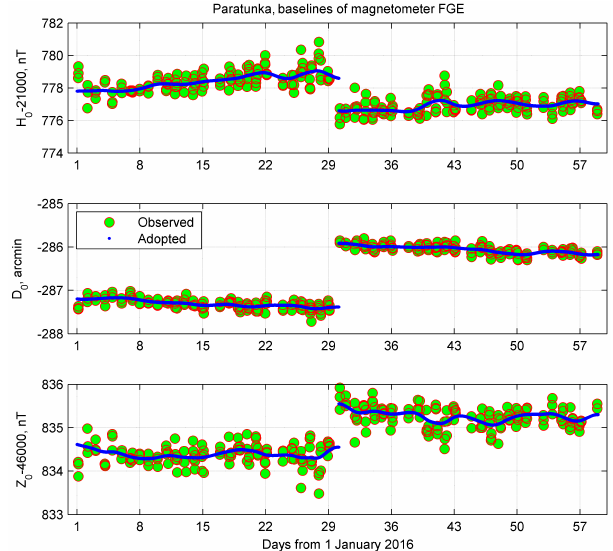
Figure 14. Baseline values of FGE variation magnetometer, Paratunka observatory, from January to February 2016. Marker (cid:13) shows individual baseline values (observed); continuous curve shows the values adopted for each minute (adopted). The jumps in baselines due to the earthquake on 30 January 2016 are clearly vis-